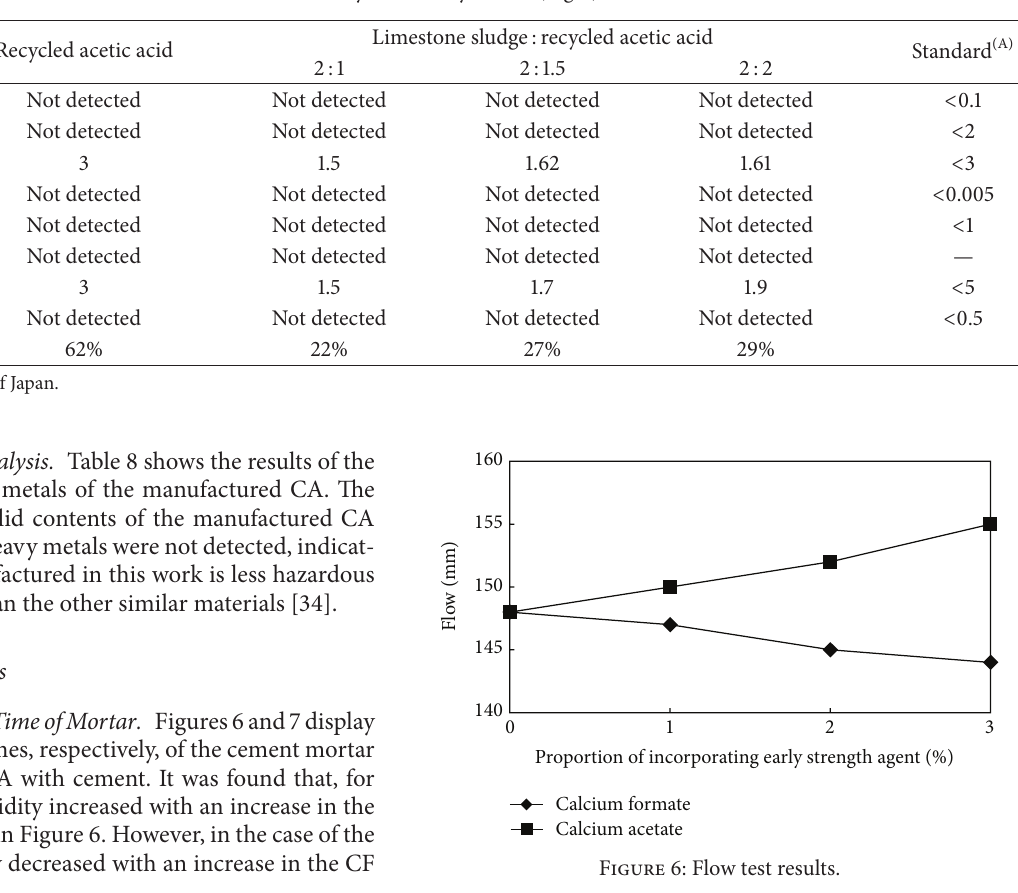
Figure 6: Flow test